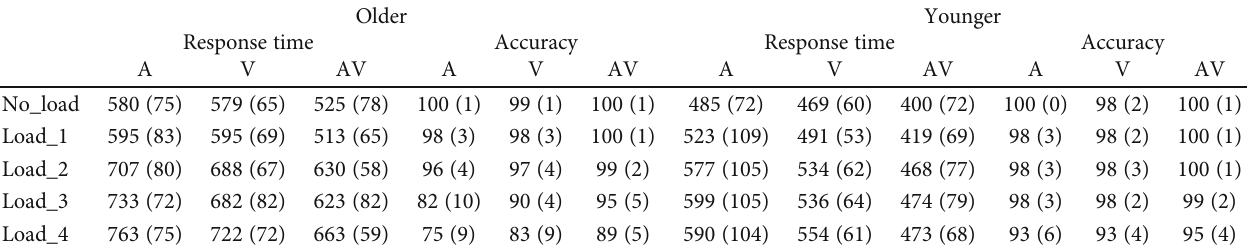
Table 1: Mean response time (ms) and accuracy (%) for older and younger adults in each condition. Older